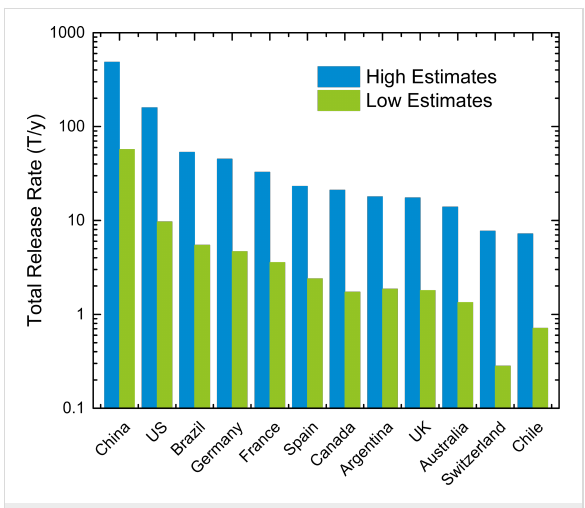
Figure 12: Estimated CeO 2 release rates for 12 selected countries.